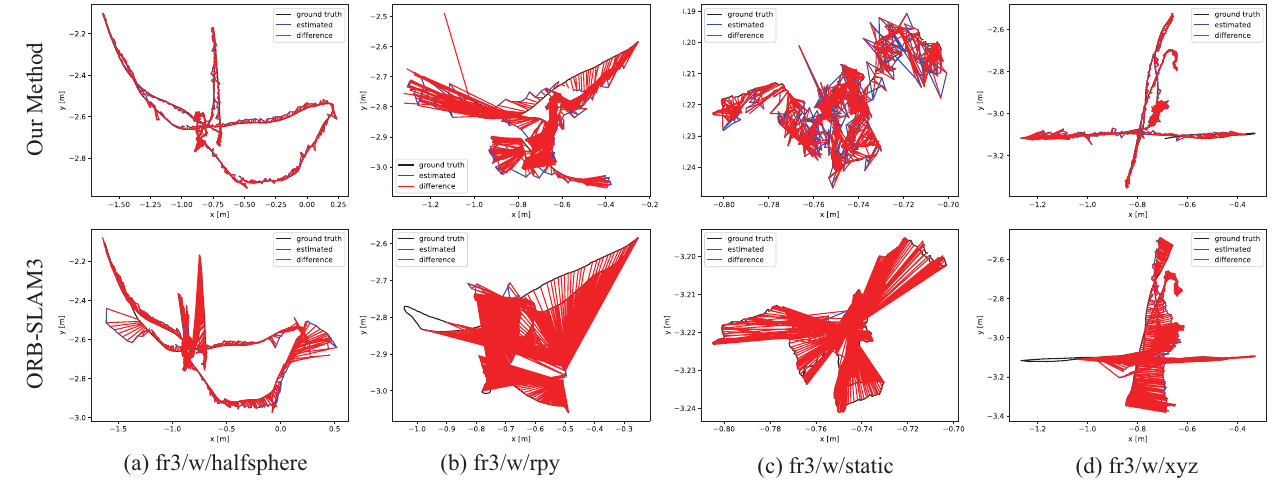
Figure 8. Comparison of ATE results between our method and ORB-SLAM3 in highly dy- namic sequences.